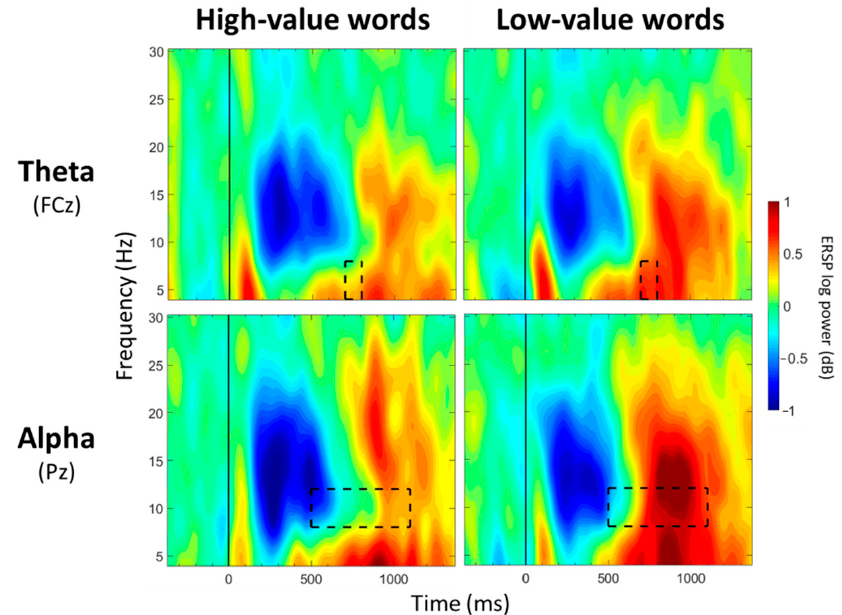
Figure 4. ERSP Comparisons for Main Effects of Value. Spectrograms illustrate differences between value (high-/low-value) for theta band (4–8 Hz) at FCz and alpha band (8–12 Hz) at Pz. The 0 ms time point (solid vertical line) represents stimulus onset. Dashed black rectangles indicate the time windows in which significant main effects of value were observed (also see Table 4).